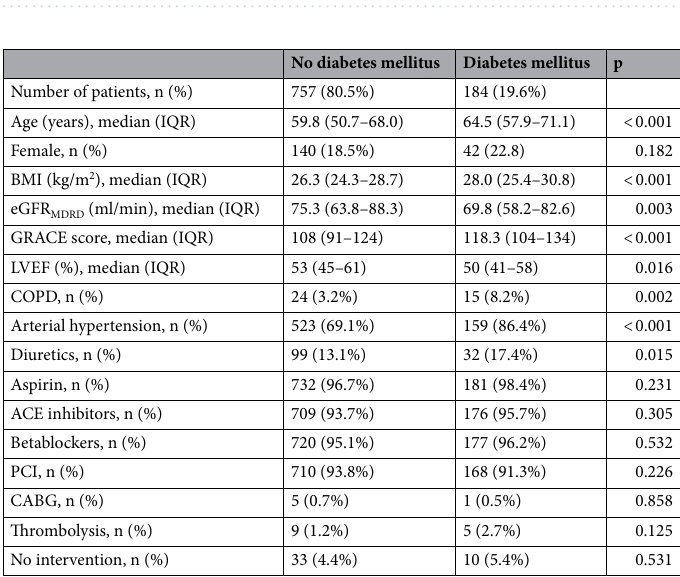
Figure 1. Study flow chart.